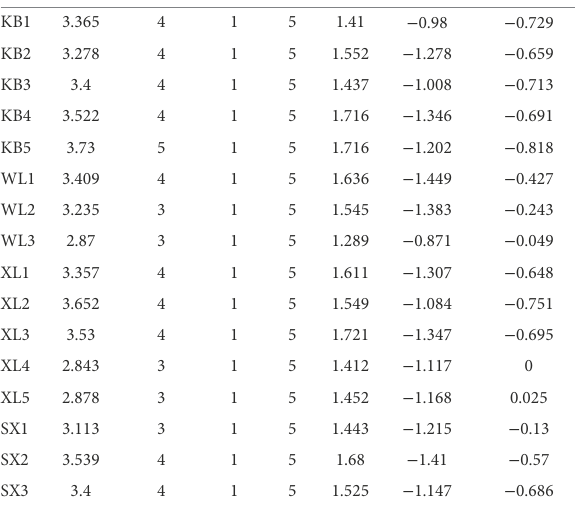
TABLE 2 Study 2: Descriptive statistical analysis of each variable (physical environment).